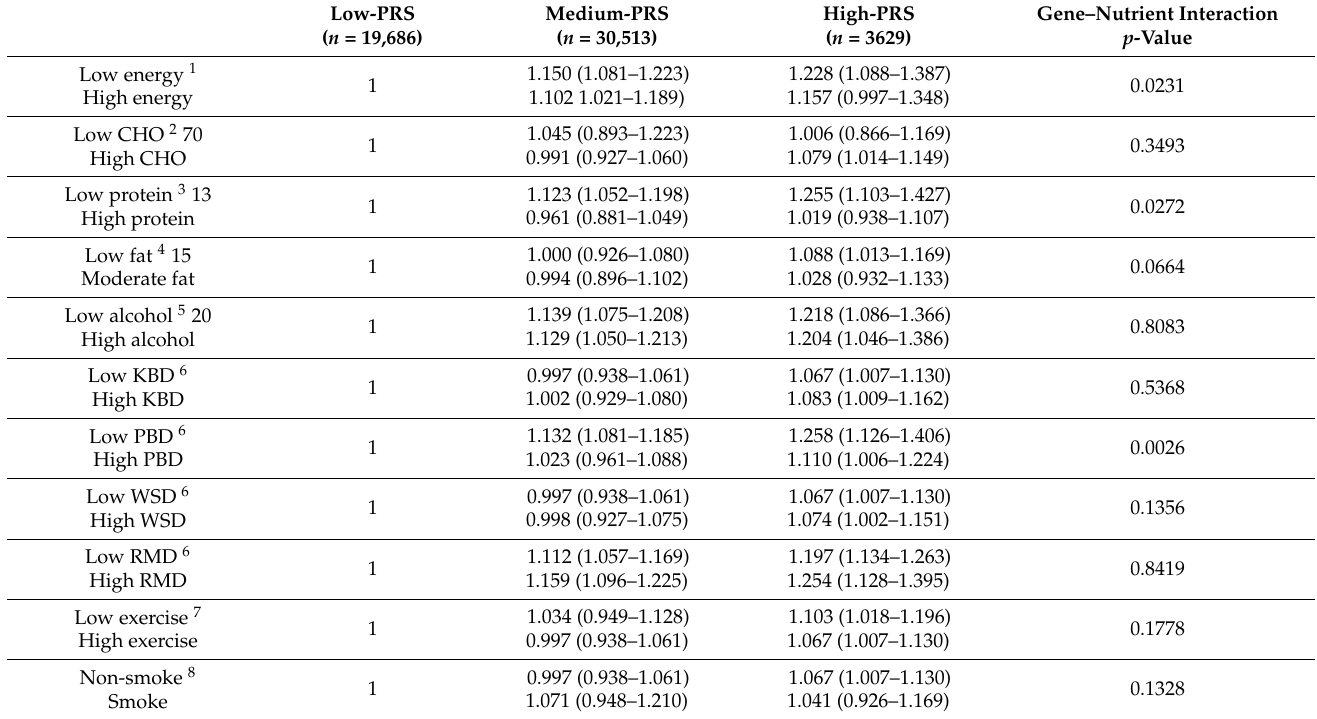
Table 6. Adjusted odds ratios for fat mass risk by polygenetic risk scores of the three-SNP model (PRS) for gene–gene interaction after covariate adjustments according to the patterns of lifestyles.